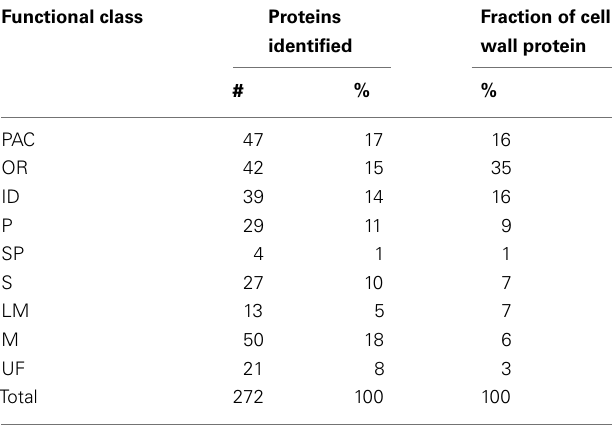
Table 2 | Distribution of identified proteins and amount of protein from alfalfa stem cell walls by functional